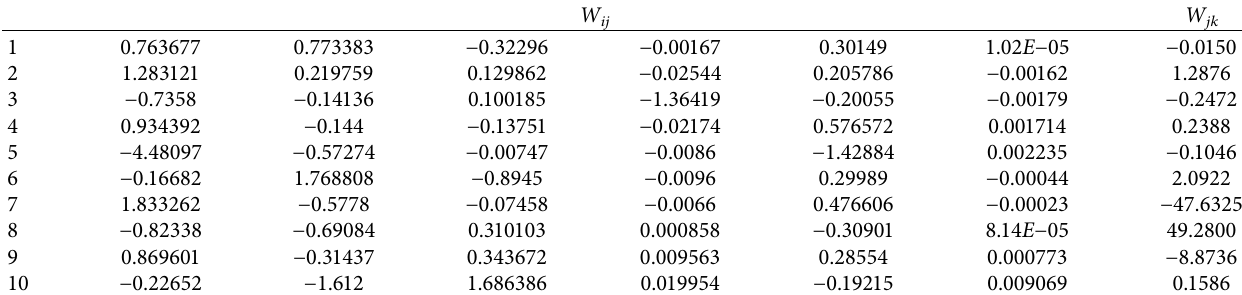
Table 2: The weight of each neuron.